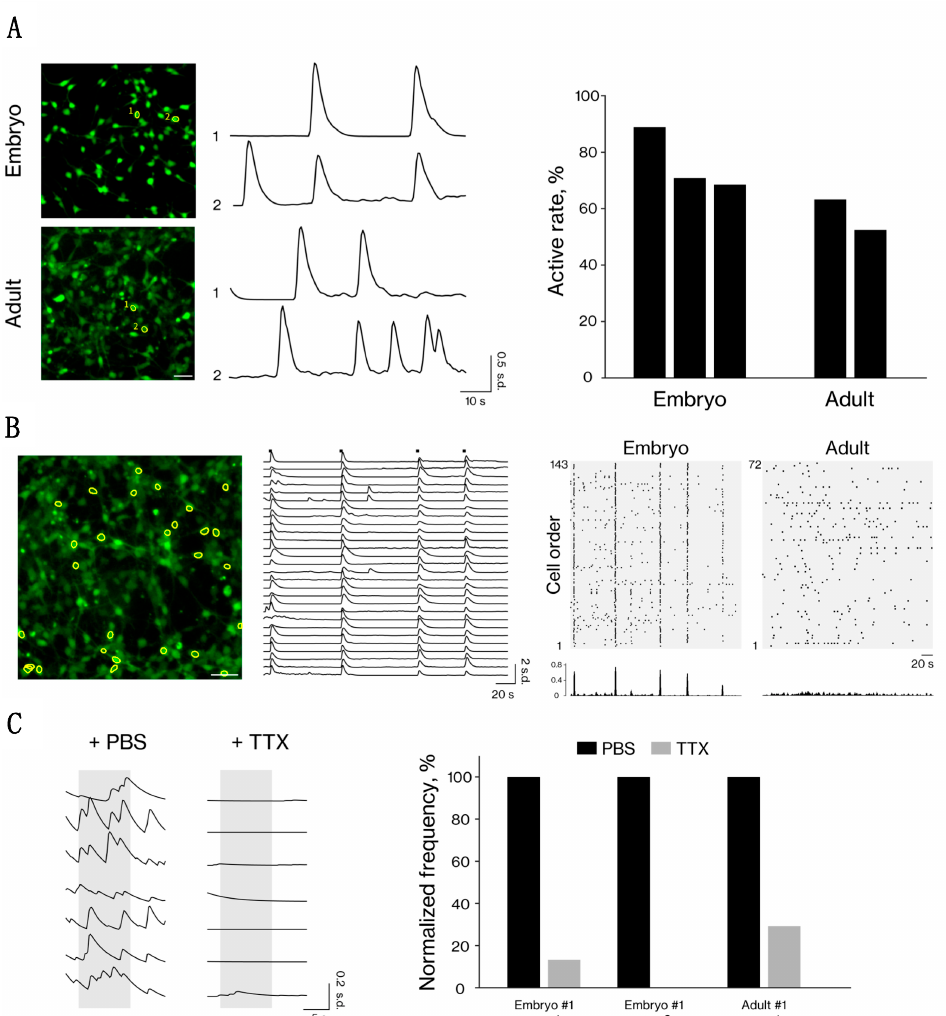
Figure 3. Functional properties of neuron-like cells from embryonic and adult fibroblasts. ( A ) Representative calcium transients of neuron-like cells from embryonic and adult fibroblasts. Left: Images of neuron-like cells in a single field of view, and time traces of the selected cells (highlighted with yellow outlines). Spontaneous neuronal activity was observed in both types of neuron-like cells after induction. Scale bar, 50 µ m. Right: The percentage of active cells. The number of Hoechst-positive cells and active cells was calculated, and both types of neuron-like cells showed high activity rates (embryonic: 79.9 ± 9.0%; adult: 57.8 ± 5.4%). Each bar shows independent experiments ( n = 3 for embryonic neuron-like cells, n = 2 for adult neuron-like cells). ( B ) Synchronized activity was detected in the embryonic neuron-like cells. Scale bar, 50 µ m. Left: Images of embryonic neuron-like cells in a single field of view. Middle: Time traces for the cells highlighted with yellow outlines. Synchronized activity patterns were observed in the embryonic neuron-like cells. Right: Upper panels show the activity patterns of embryonic and adult neuron-like cells visualized by a raster plot. Black dots indicate calcium events. Notably, synchronized activity patterns were obvious in the embryonic neuron-like cells, but not in the adult neuron-like cells. Lower panels show the histogram of the normalized active cell numbers at each time point. ( C ) Effects of phosphate-buffered saline (PBS) and the sodium channel blocker tetrodotoxin (TTX) on embryonic and adult neuron-like cells. Left: Representative calcium transients of neuron-like cells from embryonic fibroblasts. Gray shading indicates 10–30 s after PBS or TTX administration. Right: Normalized frequencies before and after administrations in embryonic and adult neuron-like cells. Each set of bars shows independent experiments ( n = 2 for embryonic neuron-like cells, n = 1 for adult neuron-like